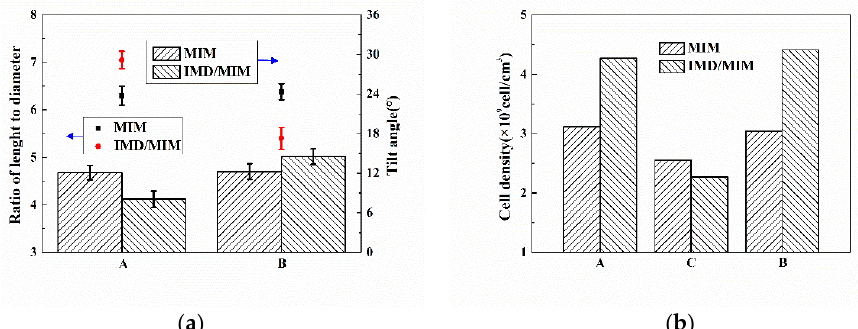
Figure 17. (a) The ratio of length to diameter and tilt angle of the transition layer A and transition layer B of MIM and IMD/MIM samples; (b) The cell density of the transition layer A, core layer C and transition layer B of MIM and IMD/MIM samples.